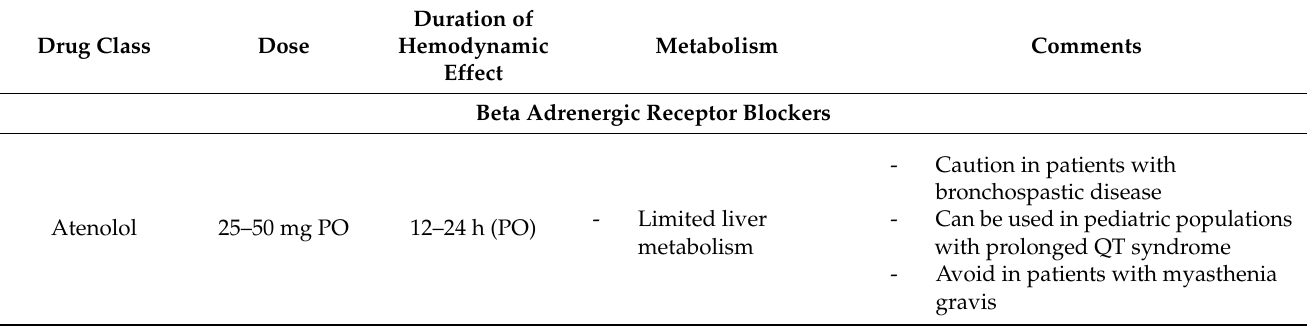
Table 4. Beta adrenergic receptor blockers, alpha 2 adrenergic receptor agonists